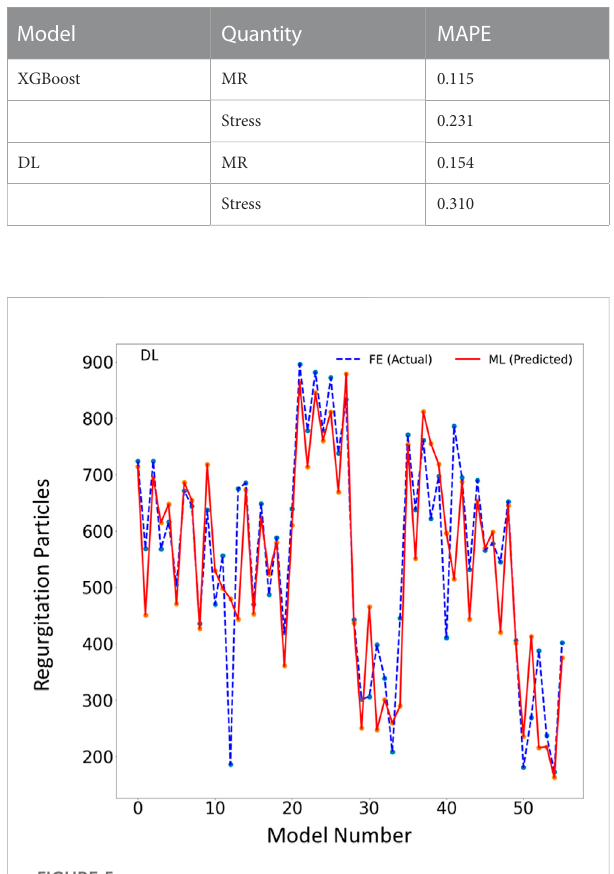
FIGURE 5 The MR results for the test set obtained from FE (ground truth) and DL (predicted). The MR is computed based on the blood particles that leakedinto leftatrium. Python(3.7,https://www.python.org/)was used to create this fi gure.